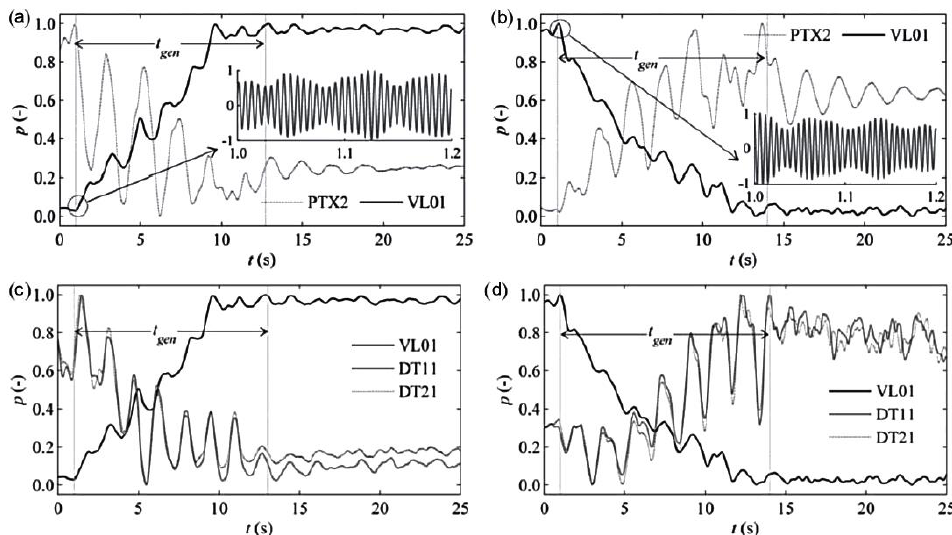
Figure 10. Evolution of transient pressure during load variations at the turbine inlet (PTX2) between the wicket gate and runner (VL01) and in the draft tube cone (DT11, DT21) [90].